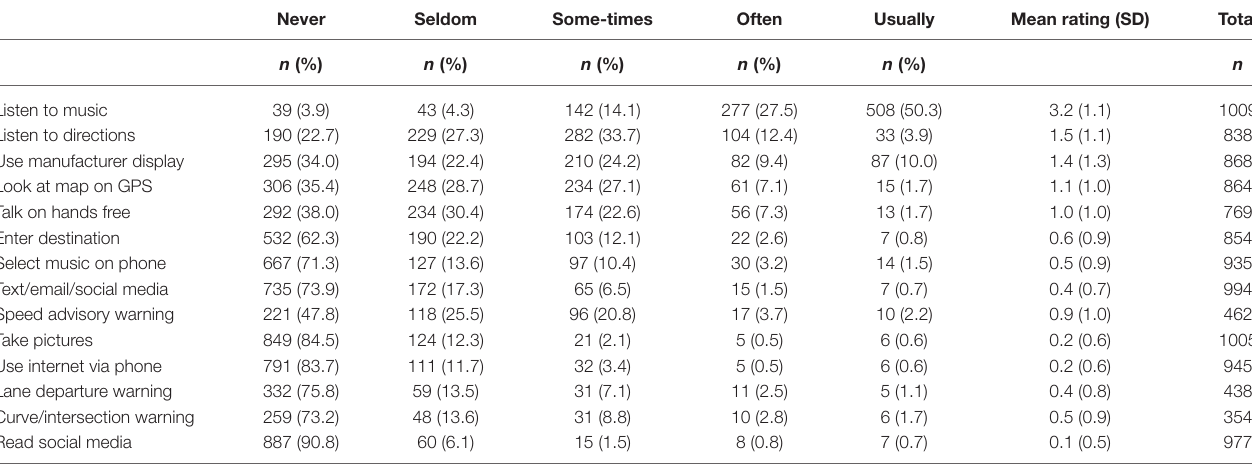
TABLE 4 | The frequency of engagement in each IVIS behavior or event (for those with access to the device/equipment) and the mean rating for frequency of use. Never Seldom Some-times Often